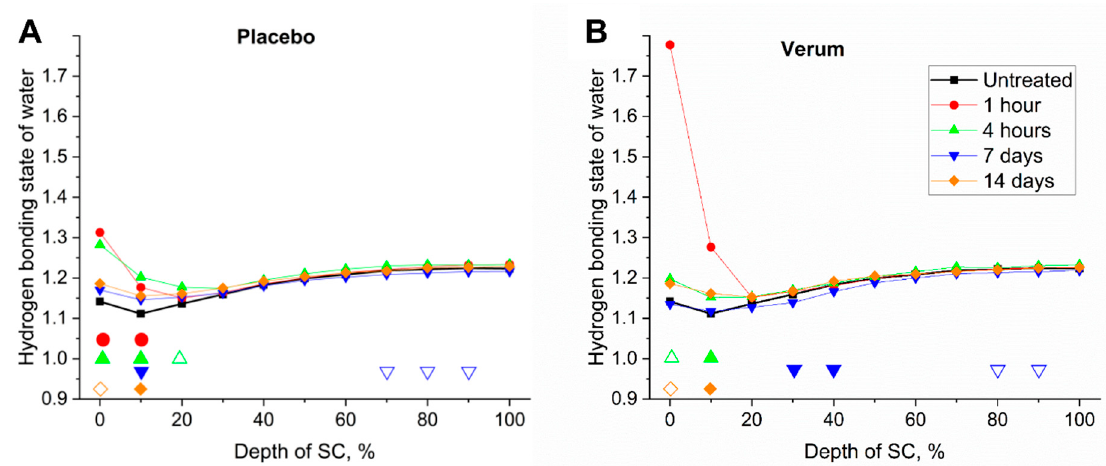
Figure 6. Mean hydrogen bonding state of water (weakly/strongly bound water ratio) of all subjects before (untreated, black squares) and 1 h (red circles), 4 h (green upward triangles), 7 days (blue downward triangles) and 14 days (orange diamonds) after the beginning of the treatment with the placebo ( A ) and verum ( B ). The signals are normalized to the thickness of the SC (0–100%). Significant differences ( p < 0.05) are marked below in empty shapes, strongly significant differences ( p < 0.01) in solid shapes. A higher hydrogen bonding state determines a higher amount of more loosely bound water, where the water is most loosely bound with surrounding molecules.